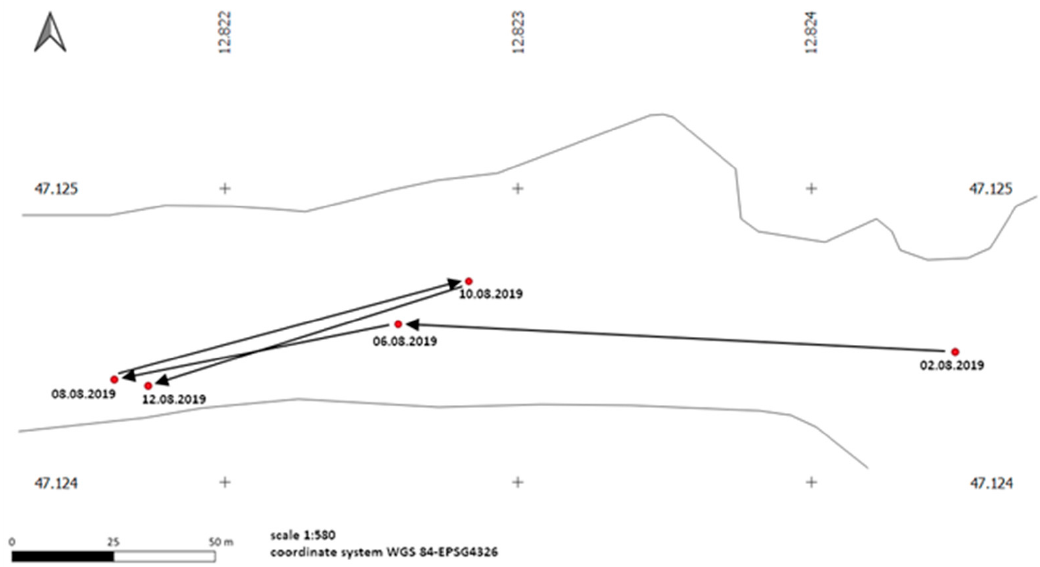
Figure 4. Example of movement patterns of a male of Erebia pronoe recaptured five times. The “+” symbols represent the grid of the coordinate system.